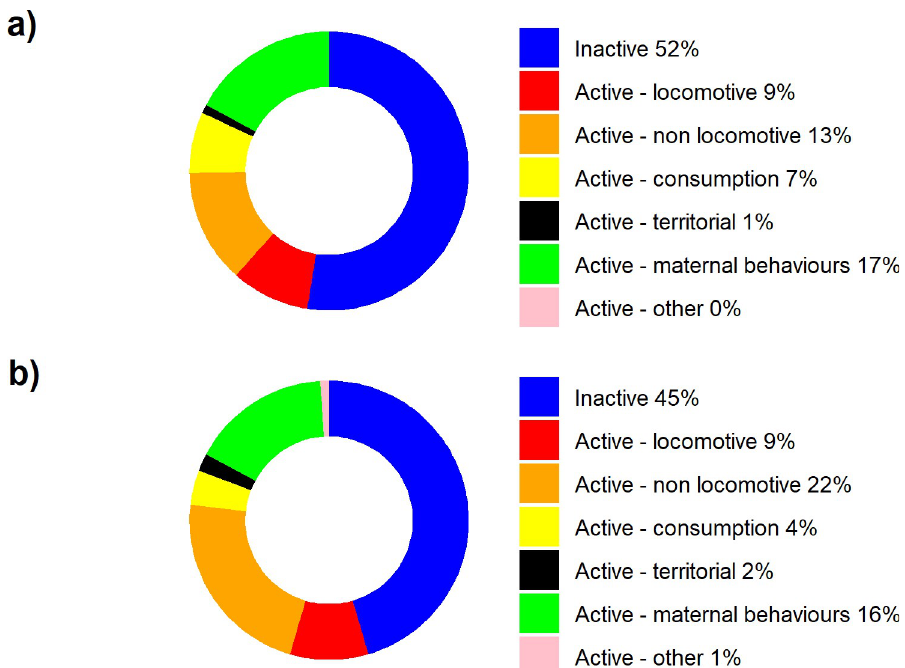
Fig 4. Main state behaviours (sub-classes) shown by the red pandas a) before collared, b) after being collared.